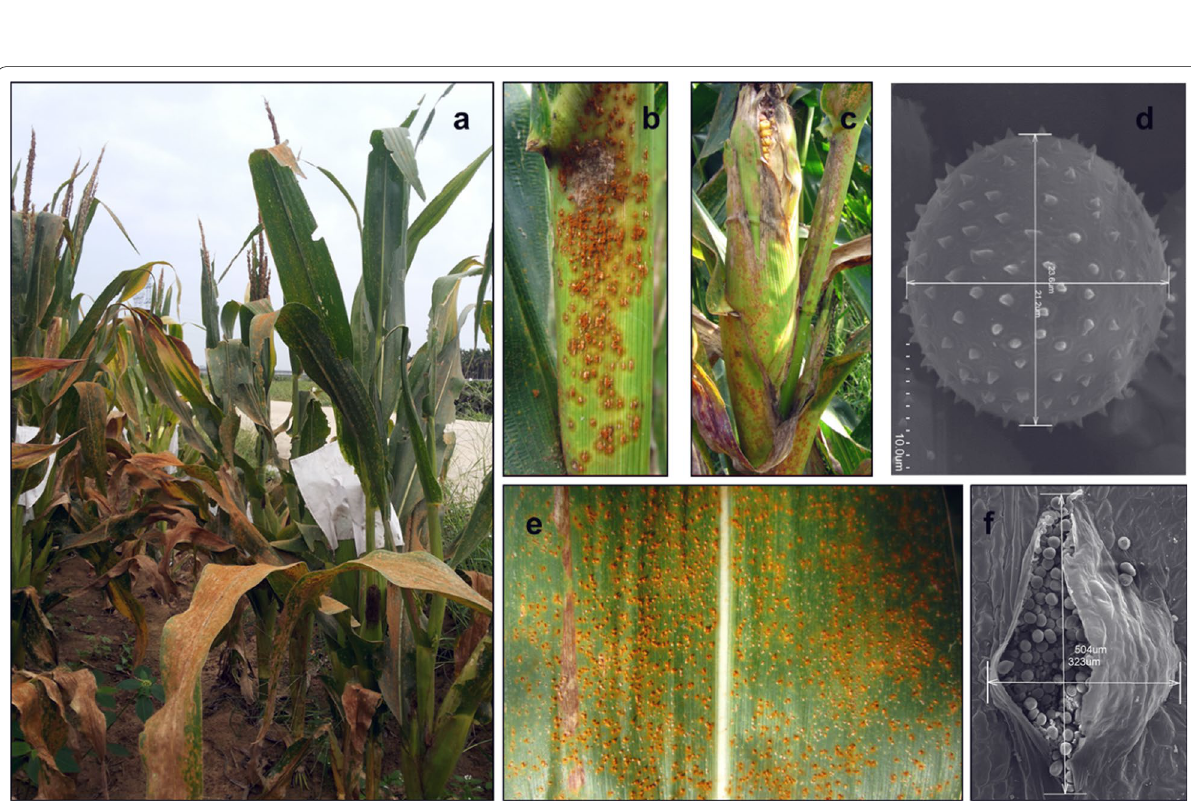
Fig. 4 Southern corn rust symptoms. a Urediniums on adult maize plants. b Urediniums on the sheath. c Urediniums on the sheaths, bracts and stem. d A urediniospore under a scanning electron microscope (SEM). e Urediniums on a maize leaf. f A uredinium under a